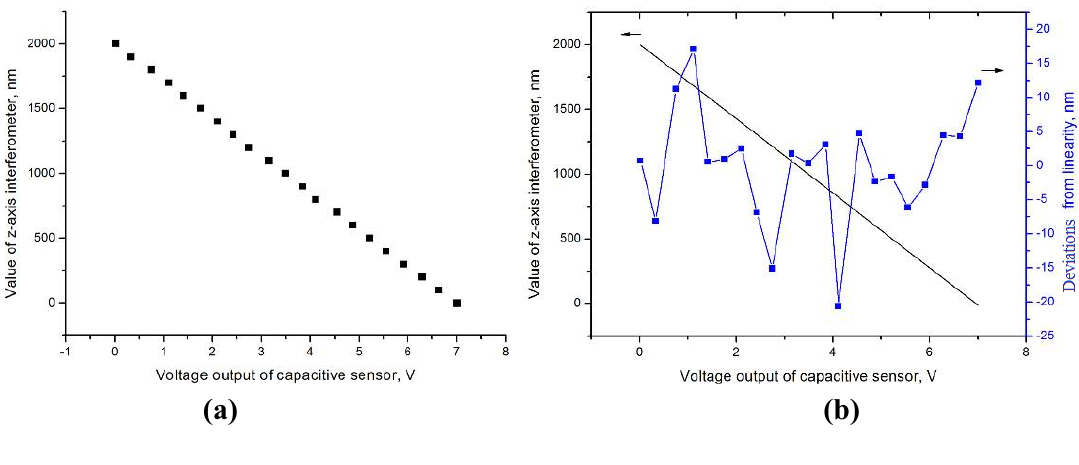
Figure 6. (a) The data collected during the calibration of the PZT stage’s capacitive sensor and (b) the calibration results.